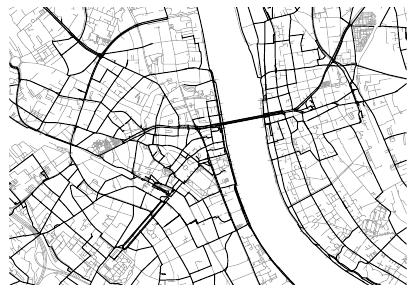
Figure 1. The road segments for a small part of our test area, classified into segments that were used by at least one trajectory (black) and those that were not used (gray). The latter includes 75.81% of all edges and 68.70% of their total